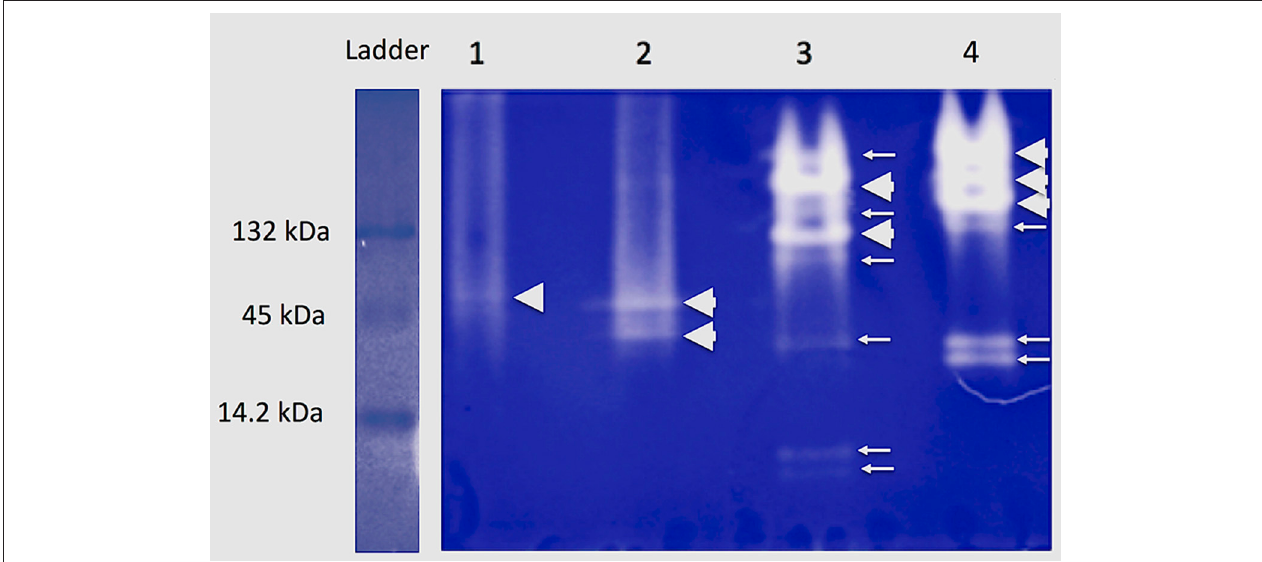
FIGURE 1 | Non-denaturing gel electrophoresis of the amylolytic activity of the purified α -amylases from the oral secretions of larvae of Chilo partellus (1), Busseola fusca (2), Sesamia calamistis (3), and Sesamia nonagrioides (4). For each species, the arrows highlight the main isoforms obtained.